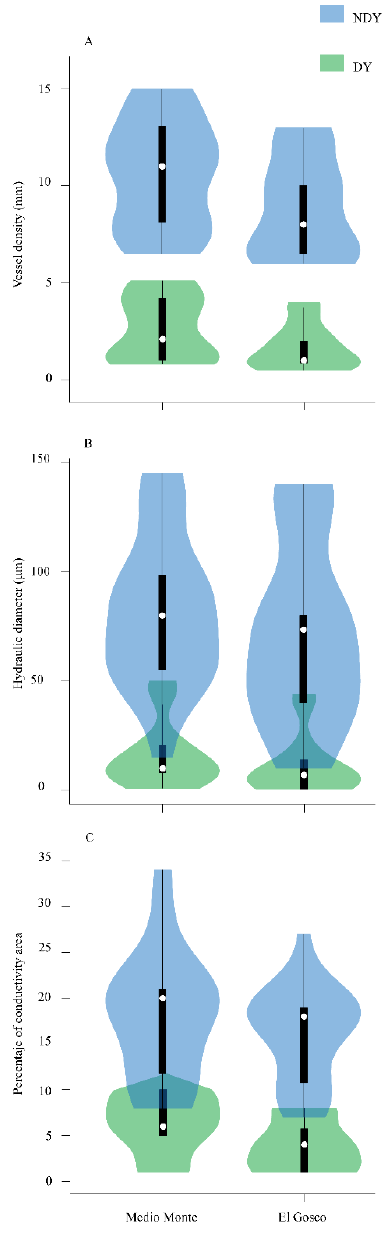
Figure 6. Violin plots showing di ff erences in vessel traits between drought years (DY) and non-drought years (NDY) for both Magnolia schiedeana populations studied. ( A ) VD; ( B ) hydraulic diameter (D h ) and ( C ) percentage of conductive area